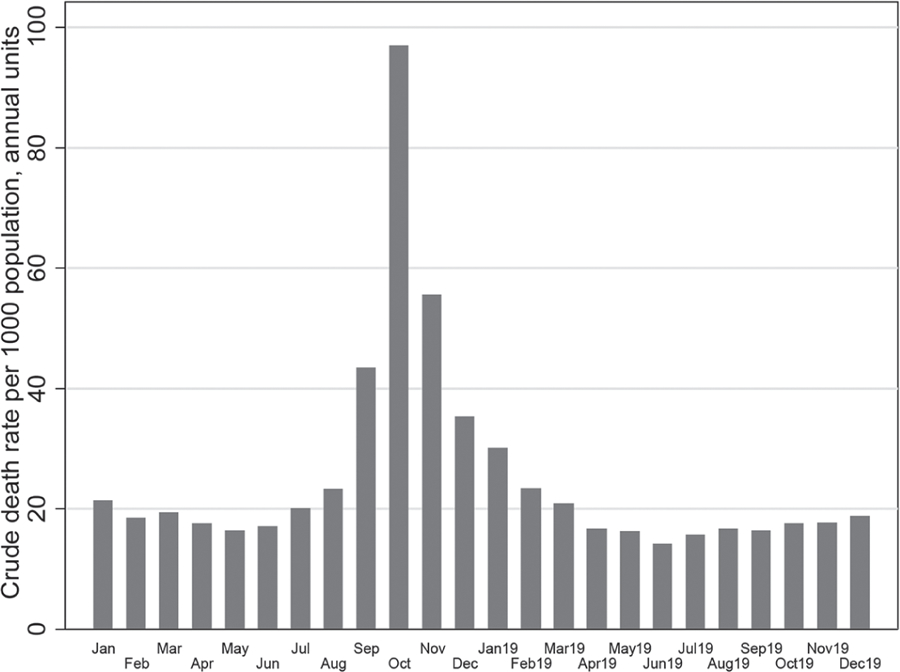
Crude death rates by month (per 1000 population) in Italy starting from January 1918. Rates computed on an annual basis. Source: authors’ estimations based on (MAIC 1924, 1925a, 1925b)